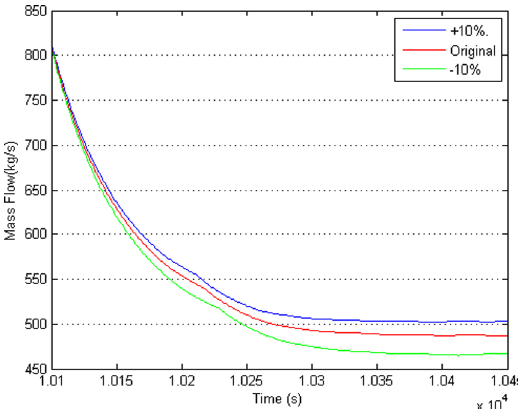
Fig. 17. Mass fl ow reduction (%) in natural convection in one loop (3D). Mean height between core and IHX sensitivity